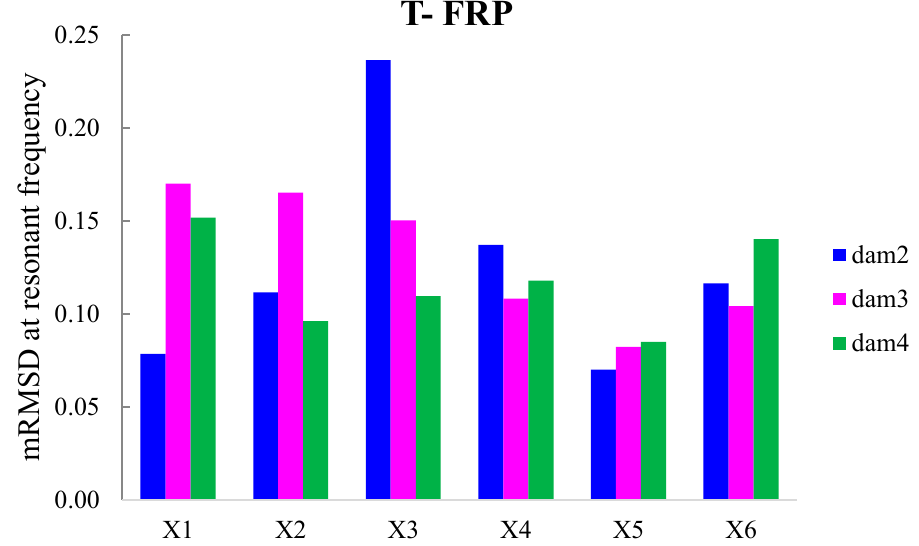
Figure 13. mRMSD at the resonant frequency of PTZs externally bonded on the surface of T-FRP.